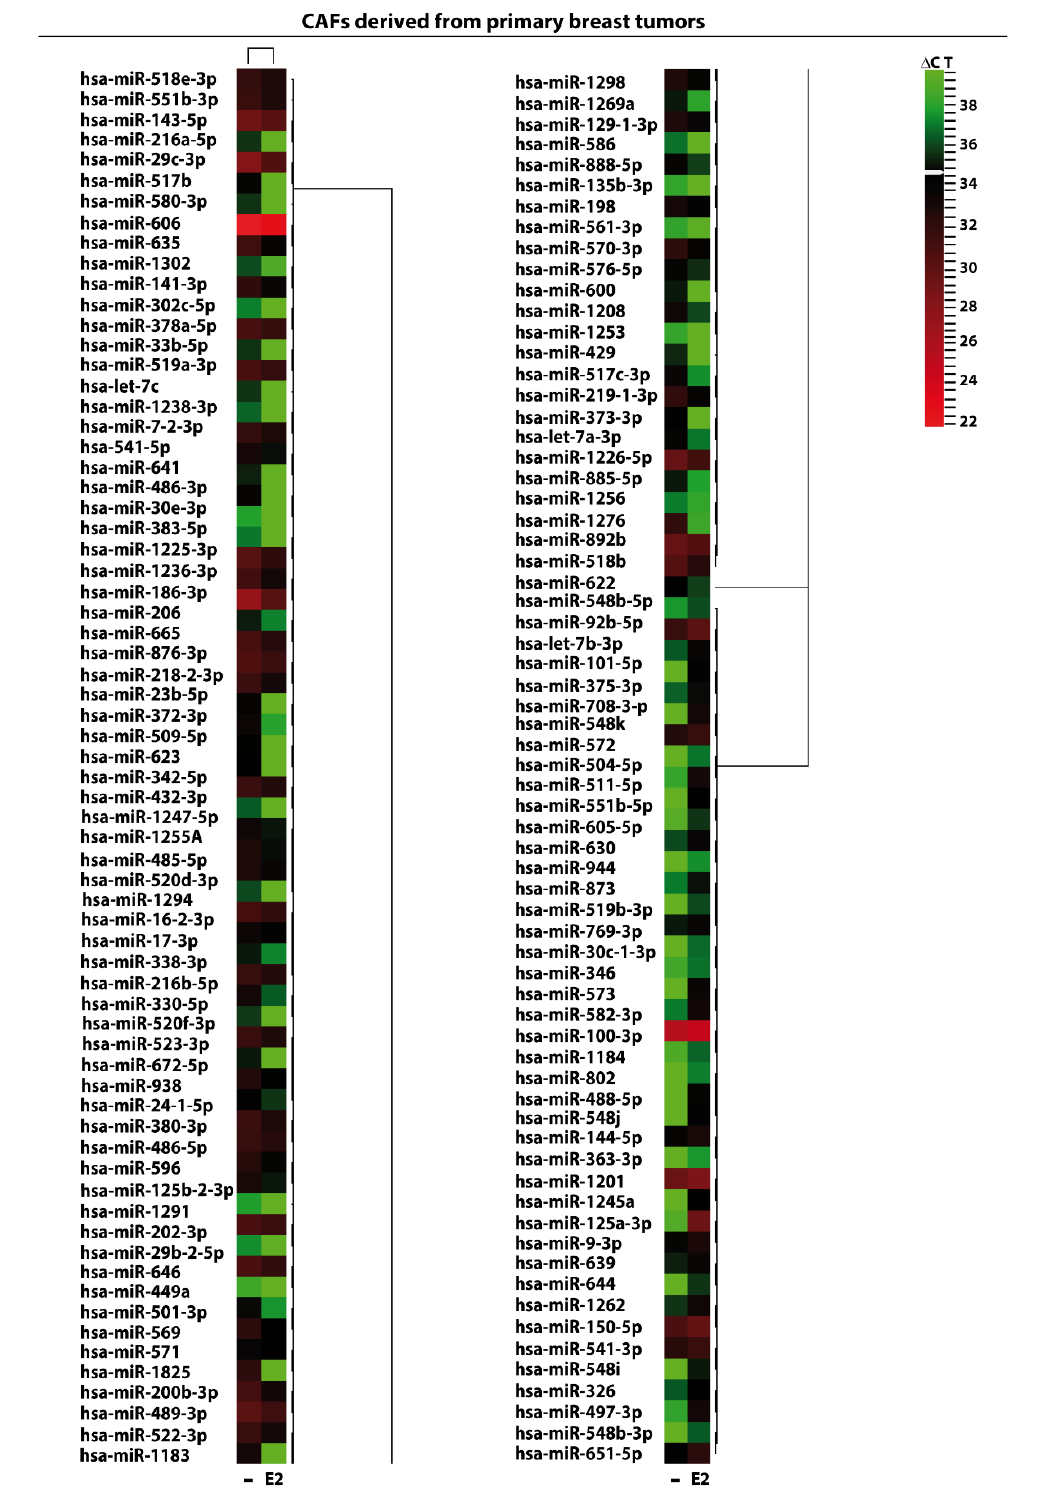
Figure 2. E2-modulated the expression of miRNAs in CAFs derived from primary breast tumors. Heat Map representation of 133 E2-regulated miRNAs in CAFs treated with 100 nM E2 for 4 h and analyzed by TaqMan Low-Density Array Human miRNA. The rows represent miRNA and columns represent the treatment exposure. Each column is illustrated according to a colour scale from green (low expression) to red (high expression). The distance measured is Euclidean Distance and the clustering method is complete linkage. Dendrograms of clustering analysis for miRNAs and samples are displayed on the top and right, respectively.